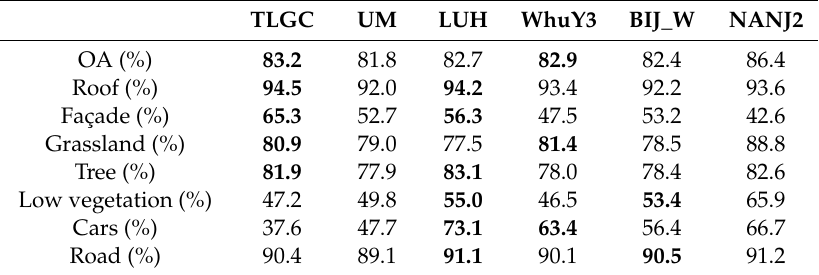
Table 7. Comparison of TLGC method and other state of art methods on ISPRS benchmark dataset in terms of F1-scores and OA. Bold numbers show the highest values and second highest values among di ff erent methods except NANJ2. TLGC UM LUH WhuY3